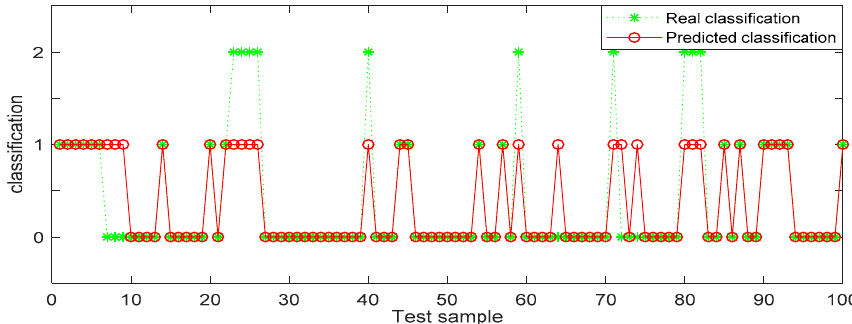
Figure 8. BP (back propagation) neural network recognition results from dataset 2.